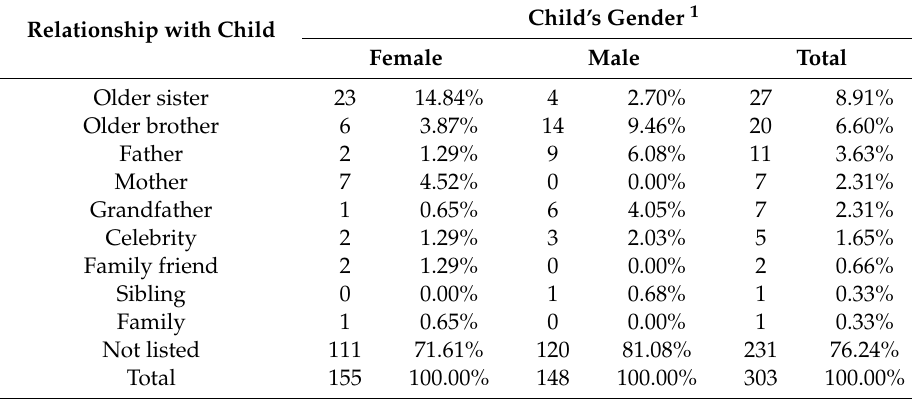
Table 2. Who the child was named for and their relationship with the child. Child’s Gender 1 Relationship with Child Female Male Total Older sister